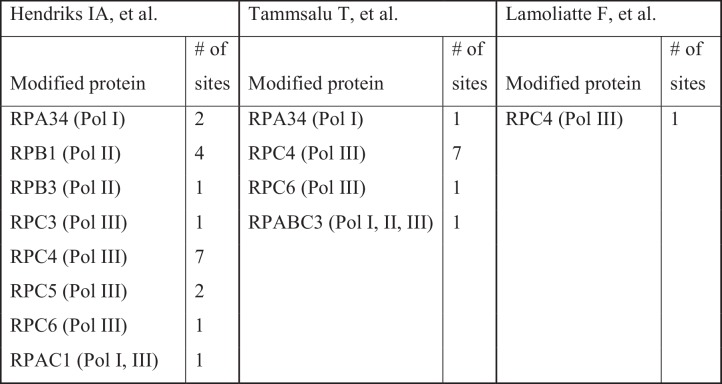
Summary of sumoylated polymerase subunits.10.7554/eLife.35447.016Figure 4—figure supplement 1—source data 1.Source data for Figure 4—figure supplement 1